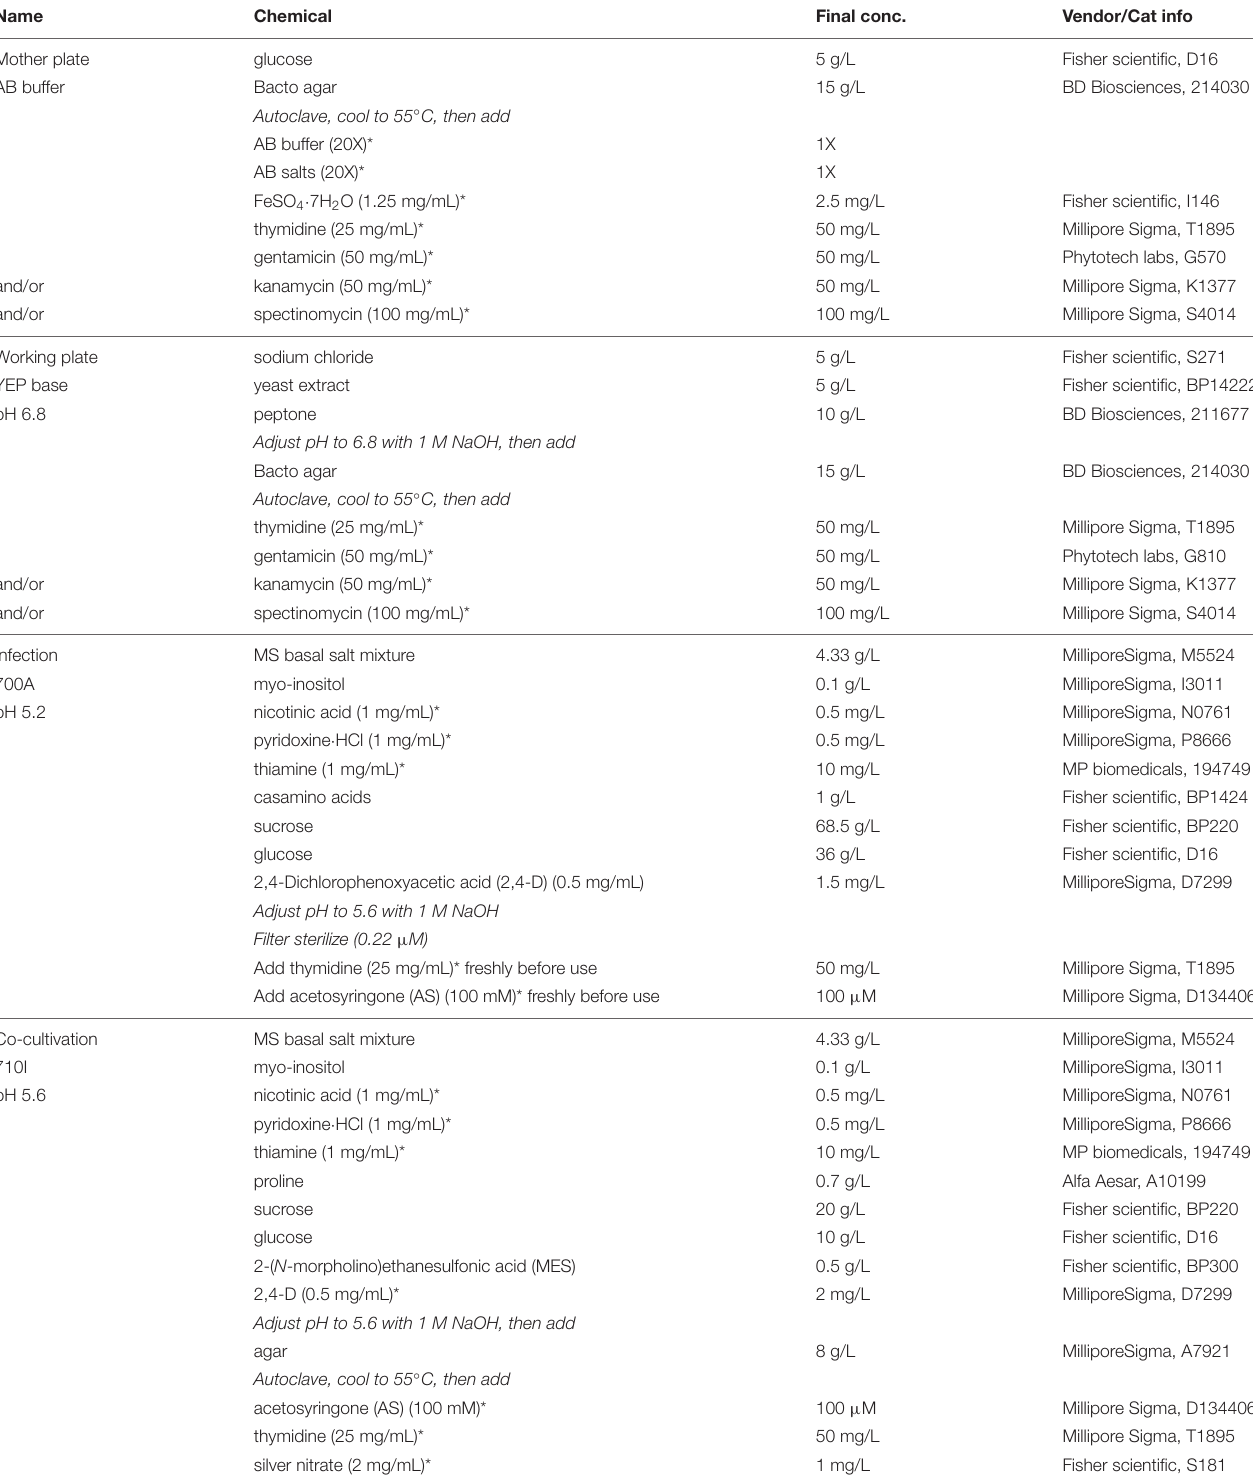
TABLE 2 | Media for B104 transformation (modified from Hoerster et al., 2020). Name Final